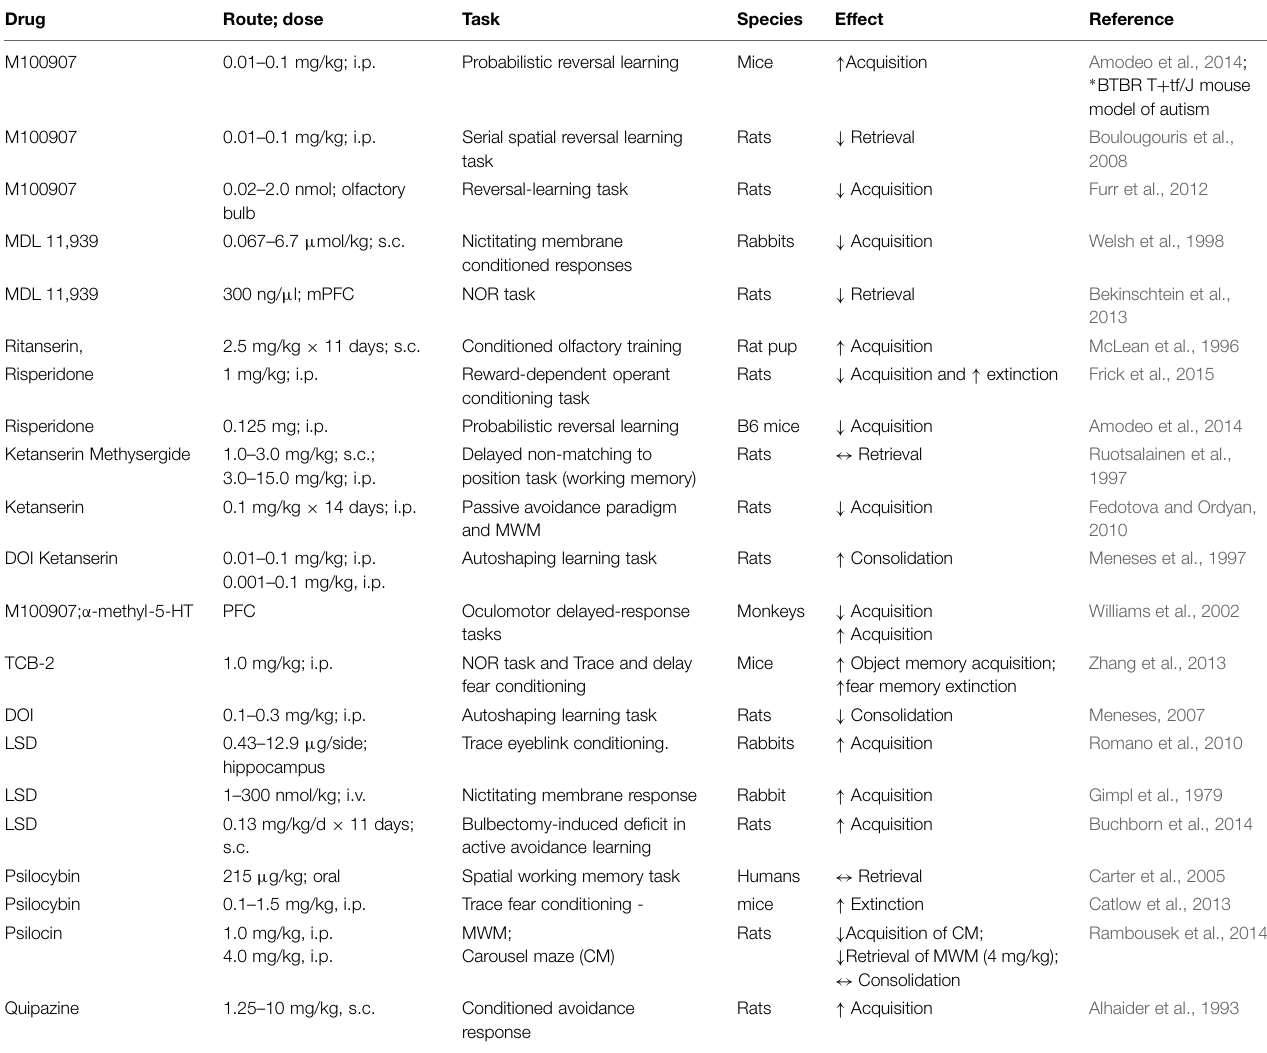
TABLE 1 | Reported effects on learning and memory after pharmacological manipulation of 5-HT 2A receptors (5-HT 2A